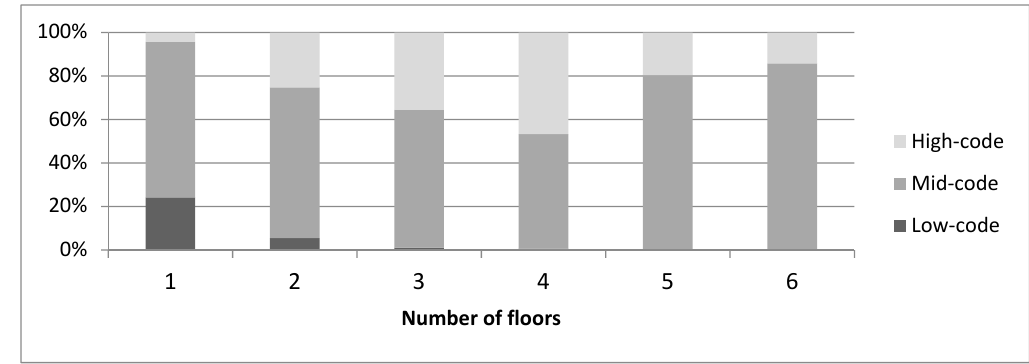
Figure 6. Distribution of the existing buildings according to number of stories and code level.